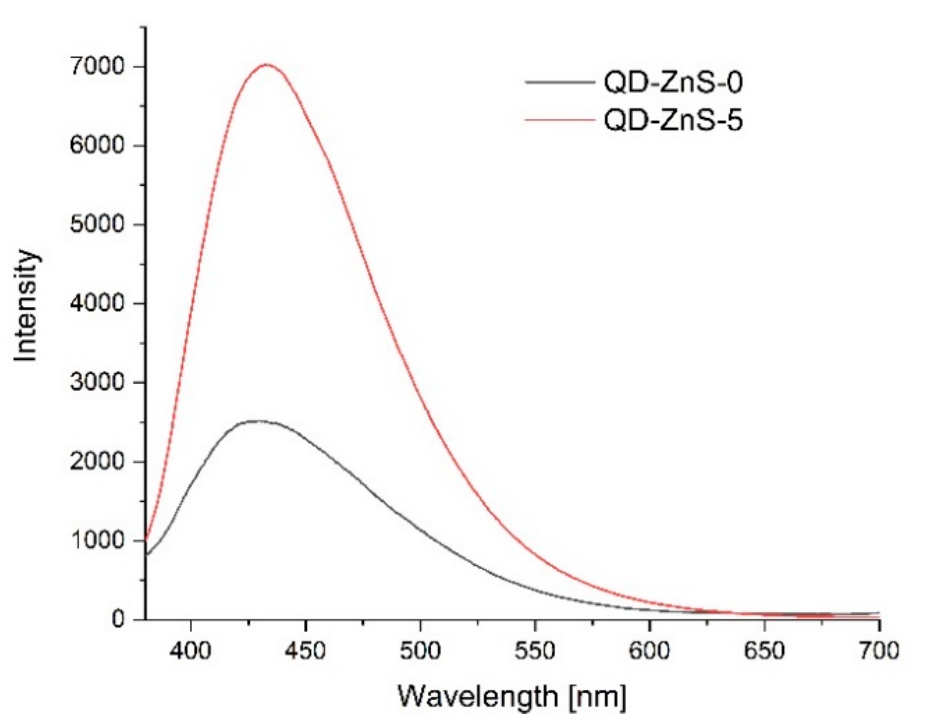
Figure 12. Emission lines of films with ZnS quantum dots before poultry meat storage (black line) and after 3 days of storage (red line).